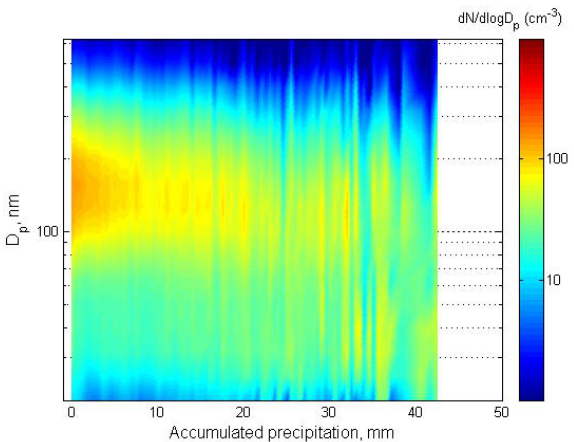
Fig. 17. Evolution of aerosol number size distribution as a function of accumulated precipitation (mm tot ) along 240 h trajectories for the dark period (October–February). Data from 2000–2010.